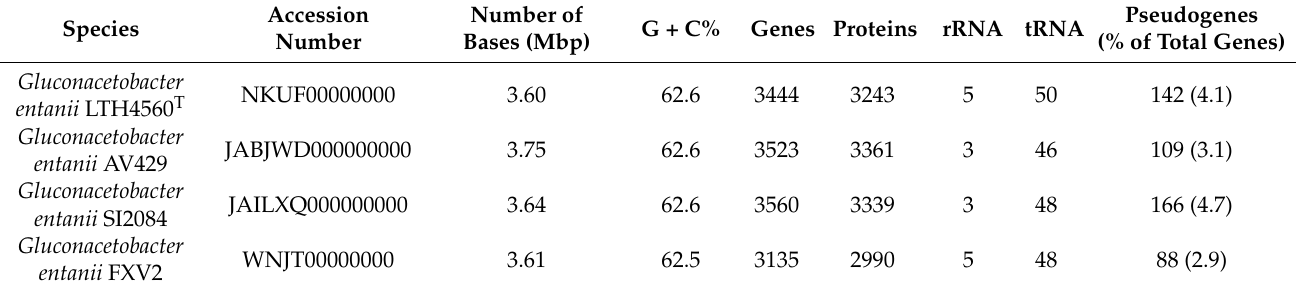
Table 2. Comparison of general genome features of G. entanii